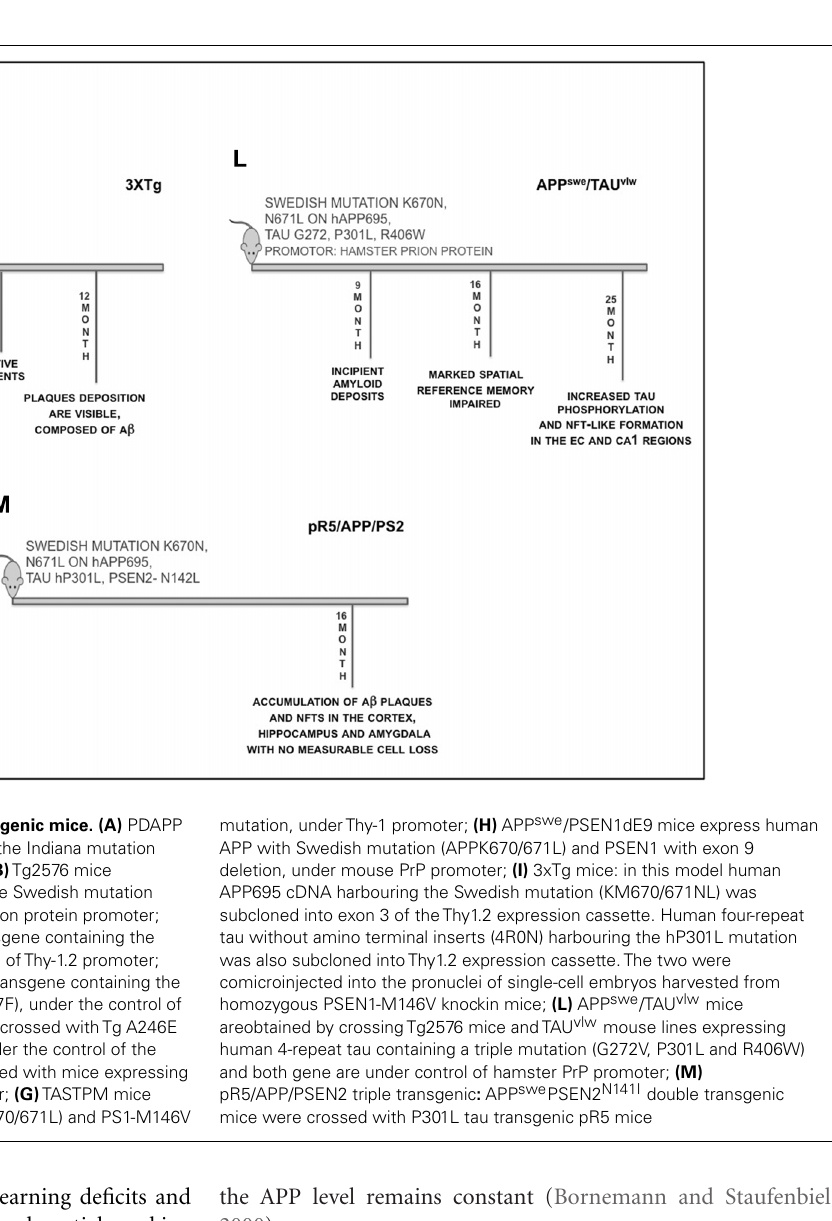
FIGURE 4 |Time-line of the main features of transgenic mice. (A) PDAPP mice overexpress human APP transgene containing the Indiana mutation (V717F) under the control of the PDGF- β promoter ; (B) Tg2576 mice overexpress human APP695 transgene containing the Swedish mutation (APPK670/671L) under the control of the hamster prion protein promoter; (C) APP23Tg mice overexpress human APP751 transgene containing the Swedish mutation (APPK670/671L) under the control ofThy-1.2 promoter; (D) CRND8Tg mice overexpresses human APP695 transgene containing the Swedish (APPK670/671L) and Indiana mutation (V717F), under the control of Syrian hamster PrP promoter; (E) Tg2576 mice were crossed withTg A246E mice (expressing a mutant human PSEN1 gene), under the control of the mouse prion protein promoter; (F) Tg2576 was crossed with mice expressing human PSEN1-M146L mutant, under PDGF promoter; (G) TASTPM mice express human APP with Swedish mutation (APPK670/671L) and PS1-M146V